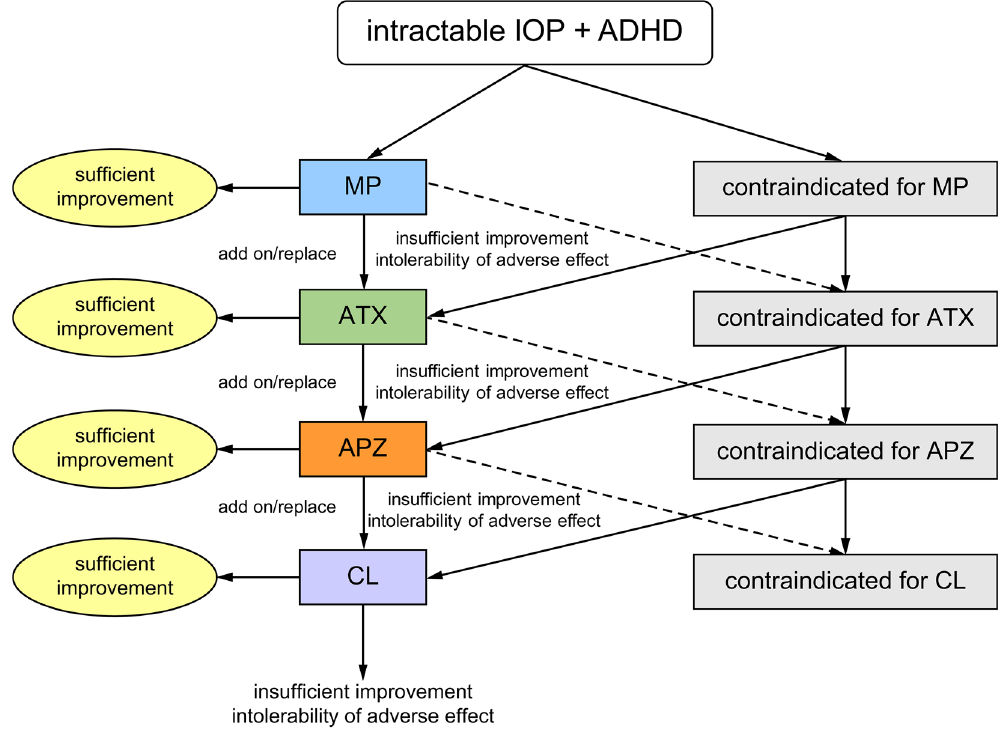
Figure 1. Medication algorithm for intractable IOP with ADHD. ADHD attention-deficit/hyperactivity disorder, APZ aripiprazole, ATX atomoxetine, CL clonidine, IOP idiopathic orofacial pain, MP